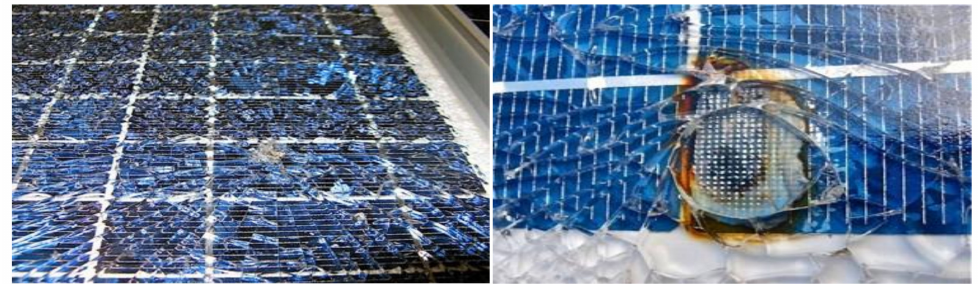
Figure 10. PV module with broken glass and cell